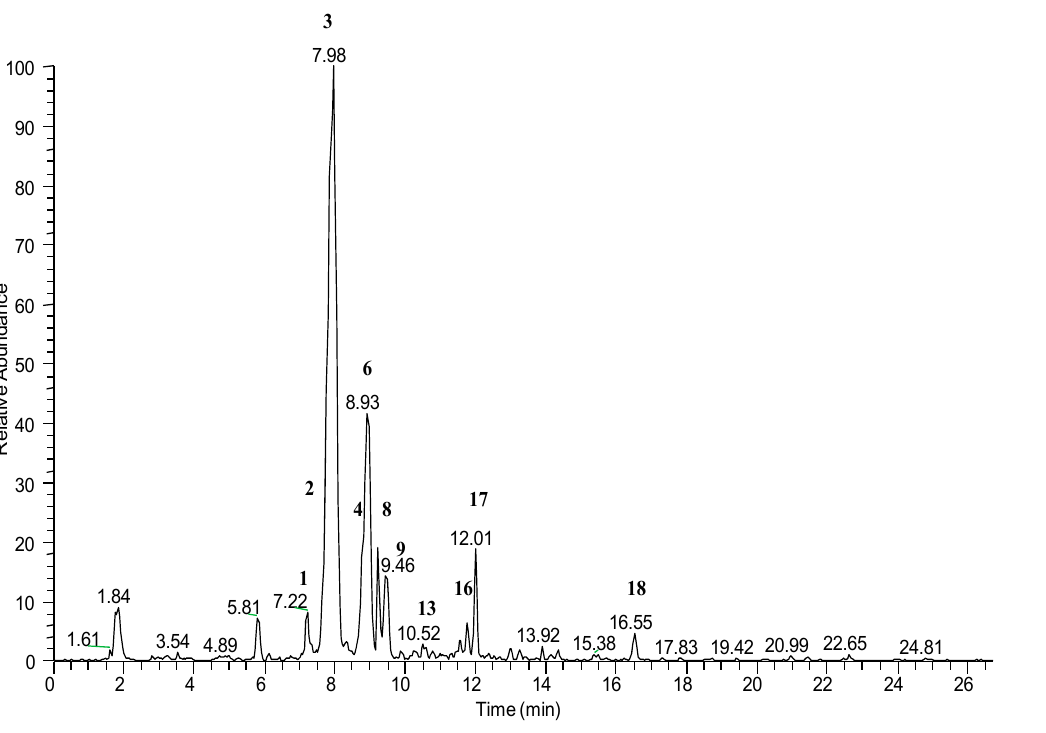
Figure 2. LC-ESI/LTQOrbitrap/MS profile in positive ion mode.